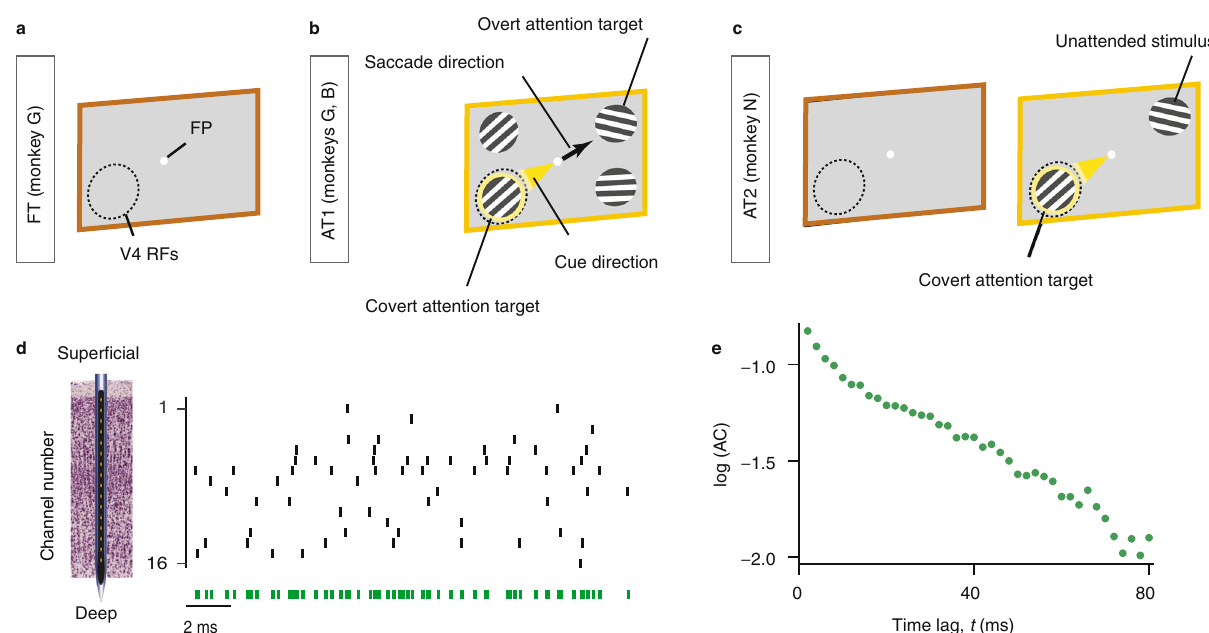
Fig. 1 | Computing autocorrelations of spiking activity in V4 columns during fi xation and attention tasks. a In the fi xation task (FT), the monkey was rewarded for fi xatingacentral fi xationpoint(FP)onablankscreenfor3soneachtrial. b Inthe attention task 1 (AT1), monkeys were trained to detect an orientation change in one of four peripheral grating stimuli, while an attention cue indicated which stimulus was likely to change. Monkeys reported the change with a saccade to the stimulus opposite to the change (black arrow). The cued stimulus was the target of covert attention(yellowspotlight),whilethestimulusoppositetothecuewasthetargetof overt attention. c In the attention task 2 (AT2), the monkey was rewarded for detecting a small luminance change in one of two grating stimuli, directed by an attentioncue.Themonkeyrespondedbyreleasingabar.Thebrownframeshowsthe blank screen in the pre-stimulus period. In all tasks, epochs marked with brown